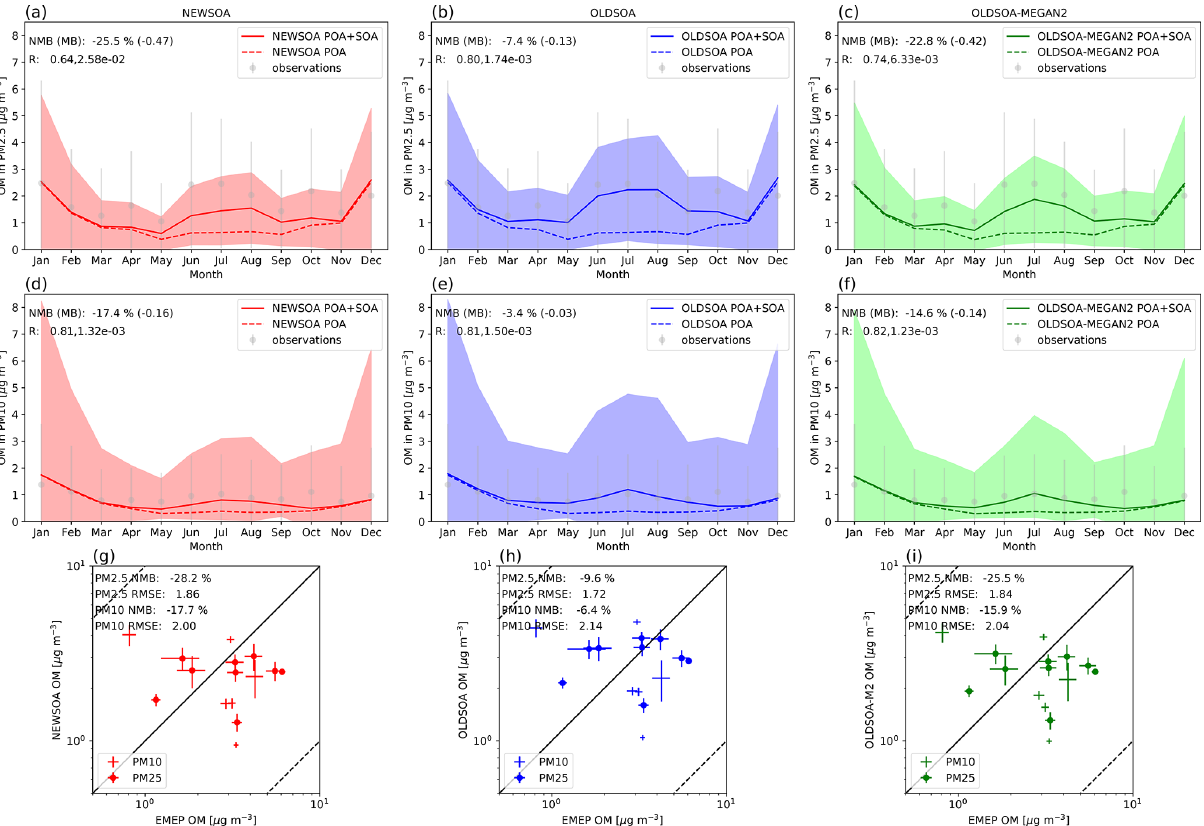
Figure 11. Organic mass concentrations at EMEP sites for the three simulations for PM 2 . 5 and PM 10 . The top row shows the annual cycle in monthly mean organic mass PM 2 . 5 concentrations for 2010 at the surface in NEWSOA (a) , OLDSOA (b) and OLDSOA-MEGAN2 (c) . The middle row shows the annual cycle in monthly mean organic mass PM 10 concentrations for 2010 at the surface in NEWSOA (d) , OLDSOA (e) and OLDSOA-MEGAN2 (f) . The modelled concentrations are collocated with observational data temporally and spatially. The shading indicates the standard deviation from the mean. Grey dots show the observed mean with the standard deviation as vertical lines. The bottom row has scatter plots of the annual mean concentration of organic mass in PM 2 . 5 ( (cid:5) with + ) and PM 10 ( + ) particles at EMEP sites in the NEWSOA (g) , OLDSOA (h) and OLDSOA-MEGAN2 (i) simulations. In the scatter plots the height and width of the line of the sign show the standard error of the mean for modelled and observed concentrations, respectively.